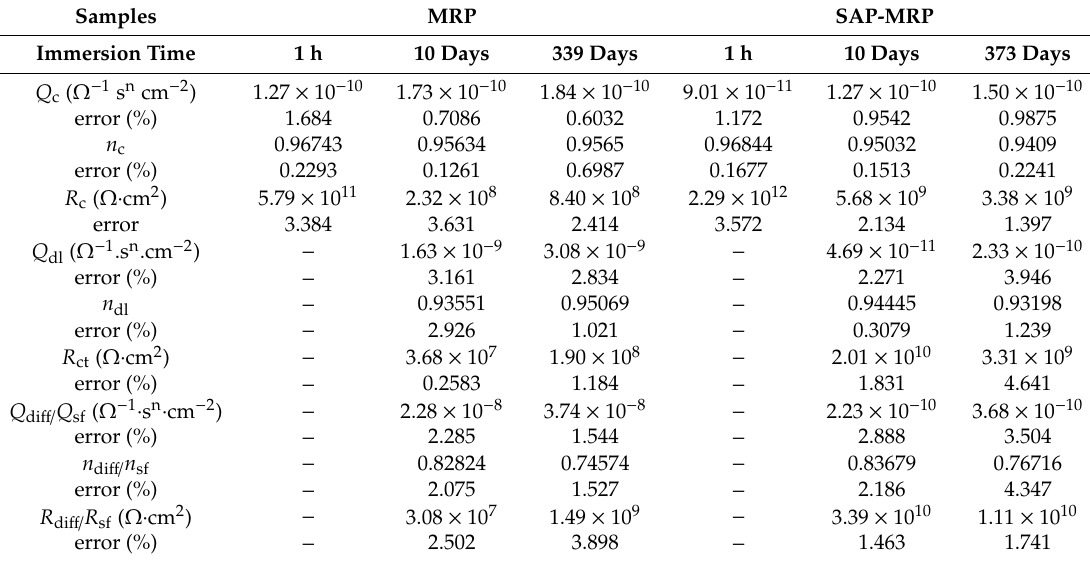
Table 4. Examples of the fitting values for the elements of each circuit with the error of the elements and chi